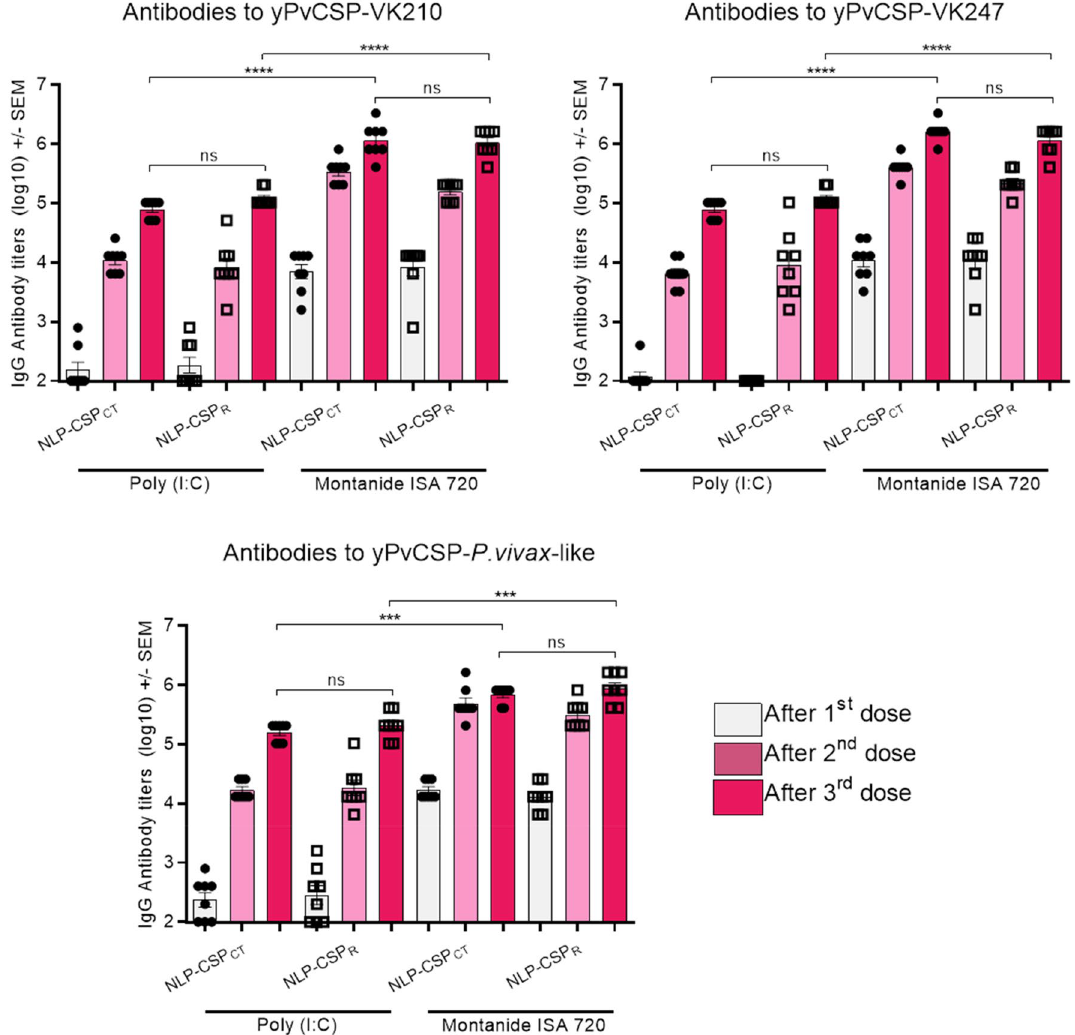
Figure 2. Humoral immune response in mice immunized with recombinant proteins. C57BL/6 mice were s.c. immunized with the recombinant NLP-CSP CT and NLP-CSP R proteins in the presence of Poly (I:C) or Montanide ISA 720 adjuvants using the scheme shown in Table 1. IgG antibody titers were determined using ELISA assay at 12 days after the administration of each dose using the individual PvCS proteins (y Pv CSP-VK210, y Pv CSP-VK247 and y Pv CSP- P. vivax -like) as solid-phase bound